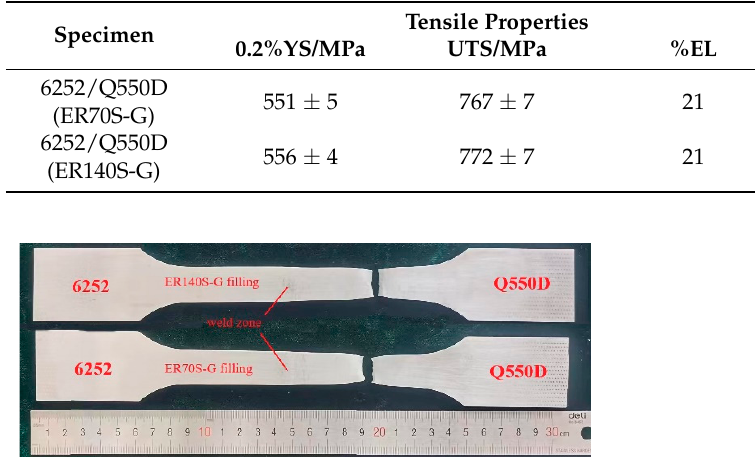
Figure 8. Hardness distribution of the weld section.